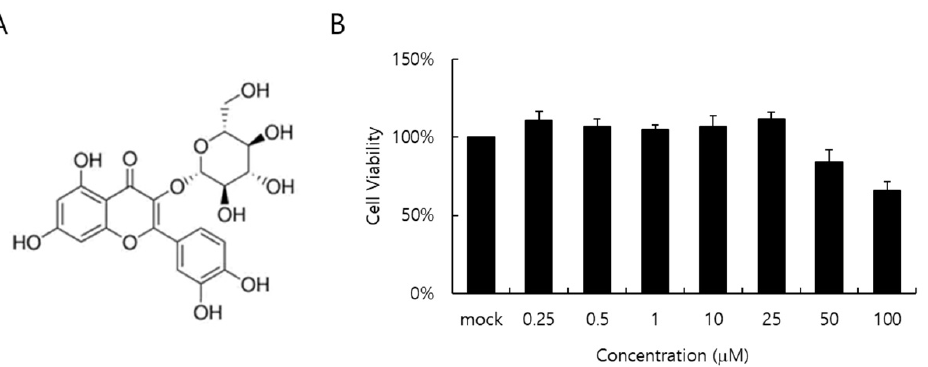
Figure 1. The chemical structure ( A ) and cytotoxicity ( B ) of isoquercitrin (IQC). IQC was treated to the RAW 264.7 cells with indicated concentrations for 24 h at 37 °C . Cytotoxicity was detected using a CCK-8 assay. The data represent the mean ± SD based on three replicates in three different experiments.